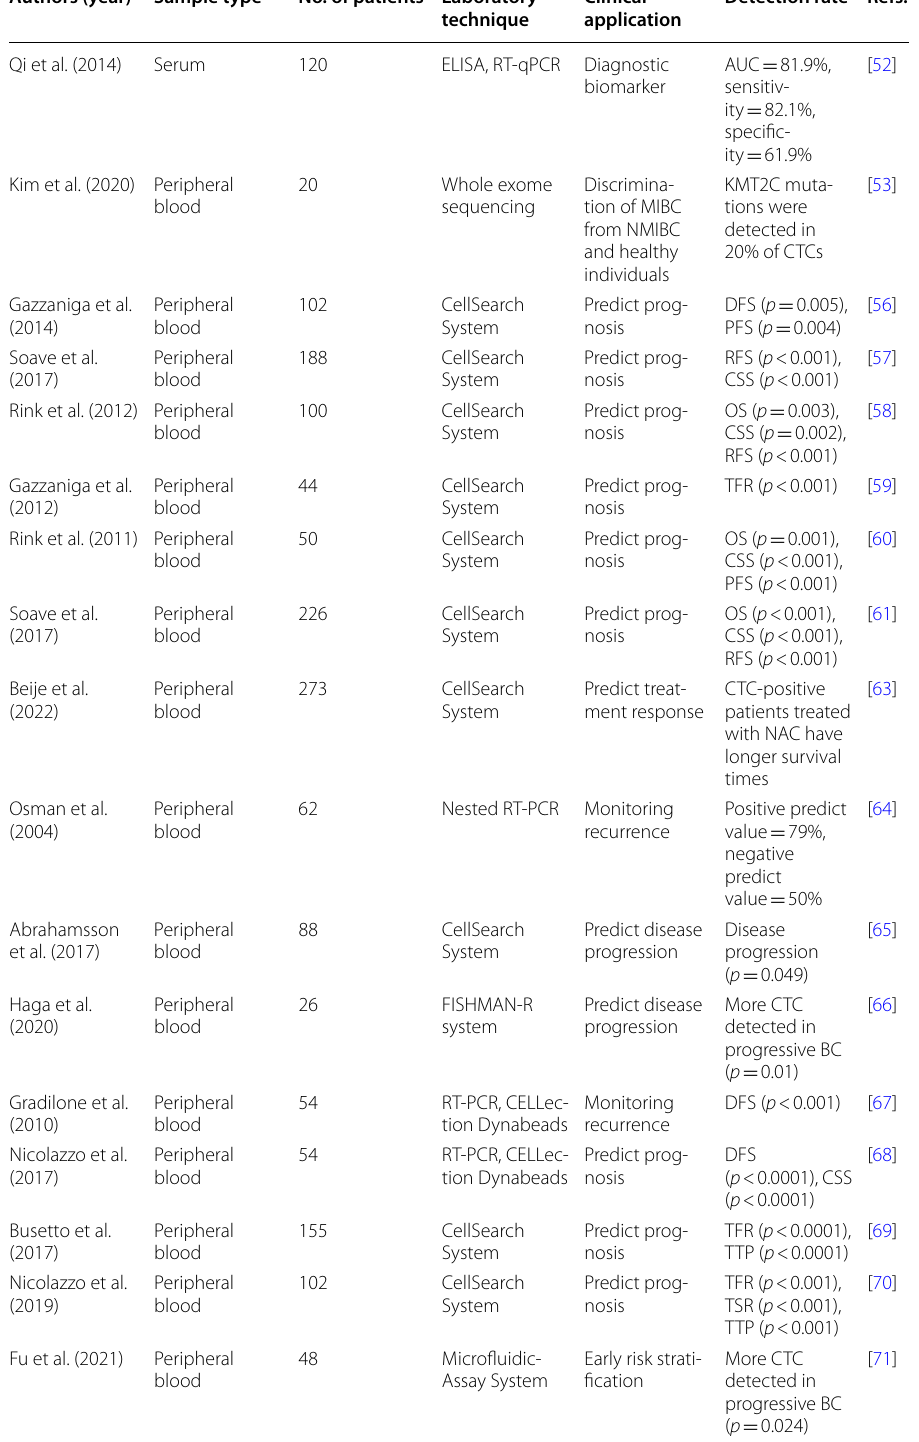
Table 1 Studies regarding blood-based CTCs as potential biomarkers for bladder cancer Authors (year) Sample